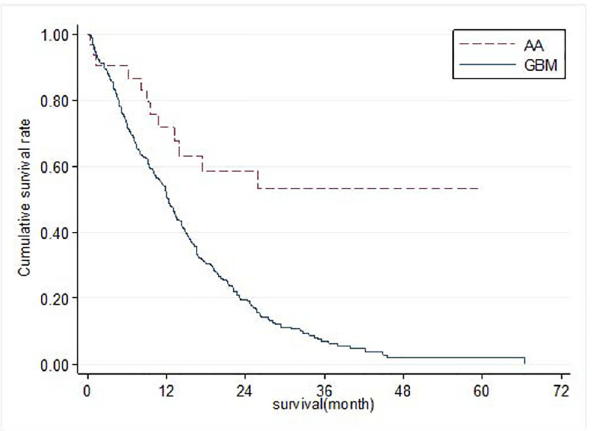
Fig 1. Overall Survival of Patients with Anaplastic Astroctyoma (AA) or Glioblastoma (GBM) in